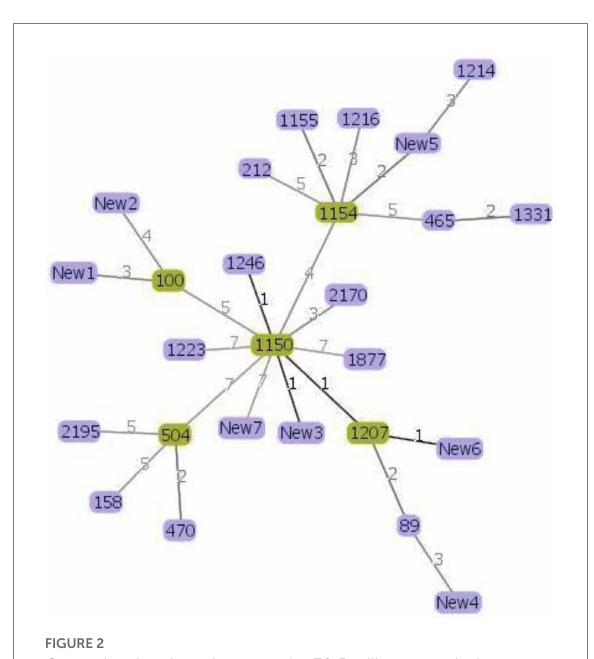
FIGURE 2 Genomic relatedness between the 30 Bacillus cereus isolates based on MLST data. The minimum spanning tree was constructed using the goeBURST algorithm implemented in the PHYLOViZ online platform. Green color represents the subgroup founders while single-locus variants are highlighted with darker